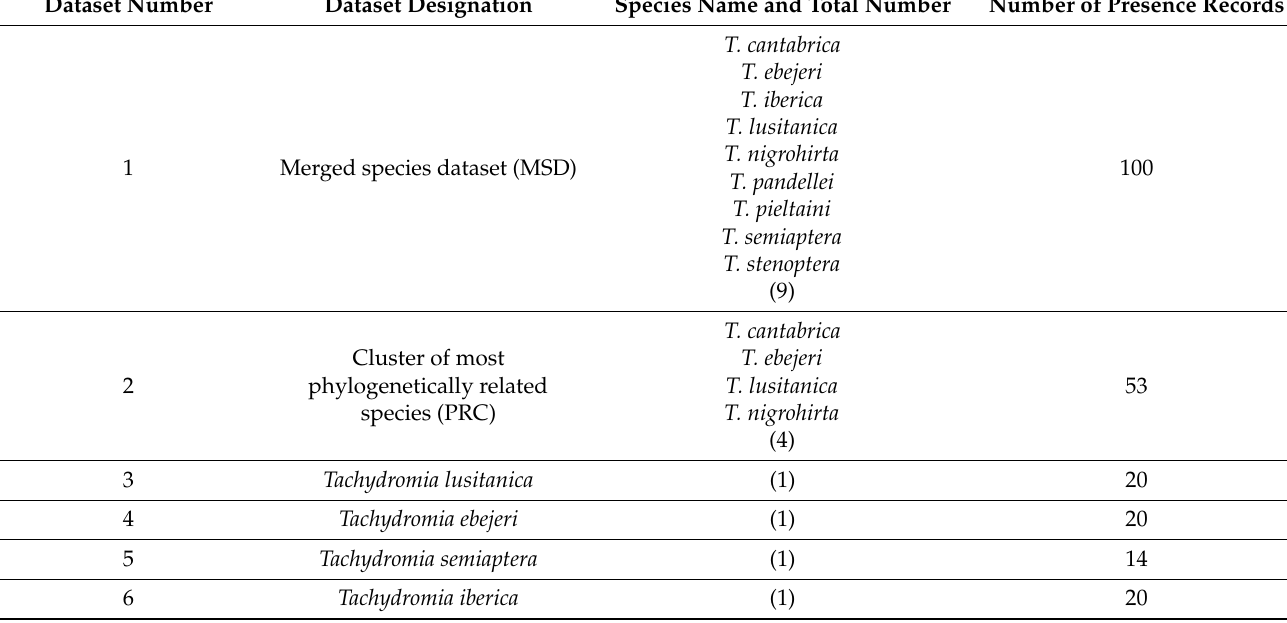
Table 1. Sets of species data used in model development. Sets 1 and 2 used a pooling strategy where, respectively, all species or the most phylogenetically related ones were combined. For sets 3 to 6, each species data was used individually without